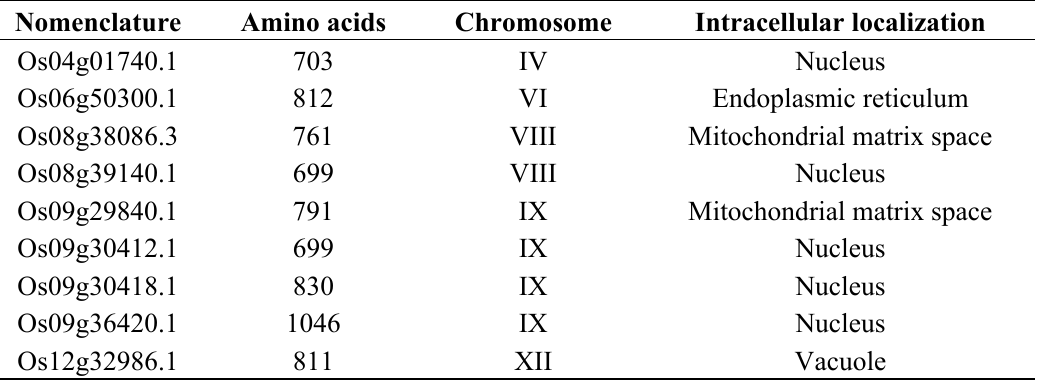
Table 4. Oryza sativa Hsp90 proteins.